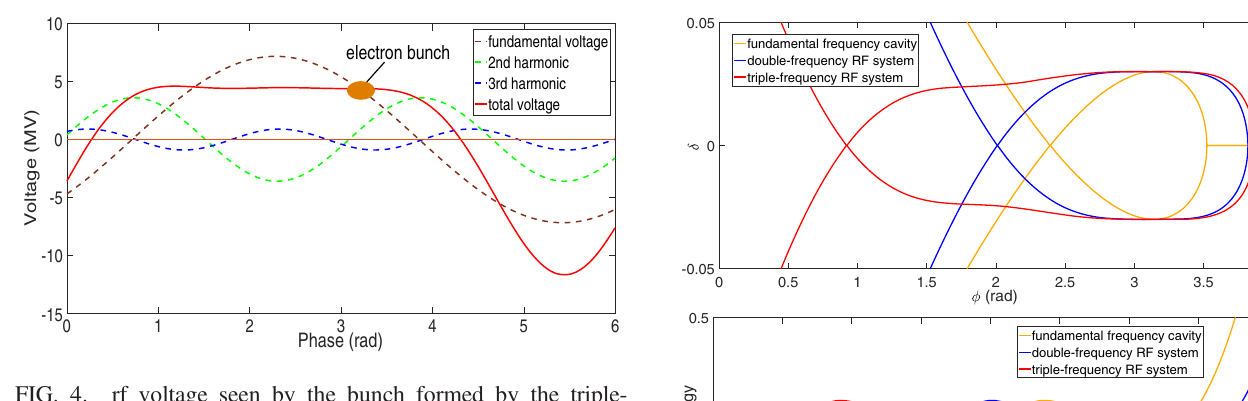
FIG. 4. rf voltage seen by the bunch formed by the triple- frequency rf system.